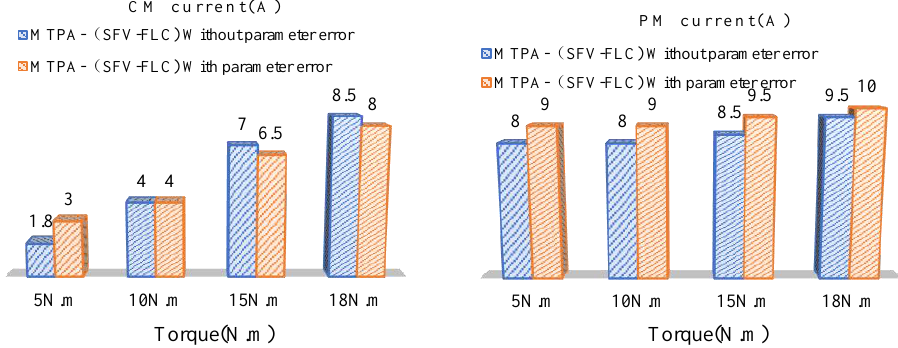
Figure 13. When the torque varies, the simulation experiment verifies the MTPA-(SFV-FLC)’s ro- bustness.